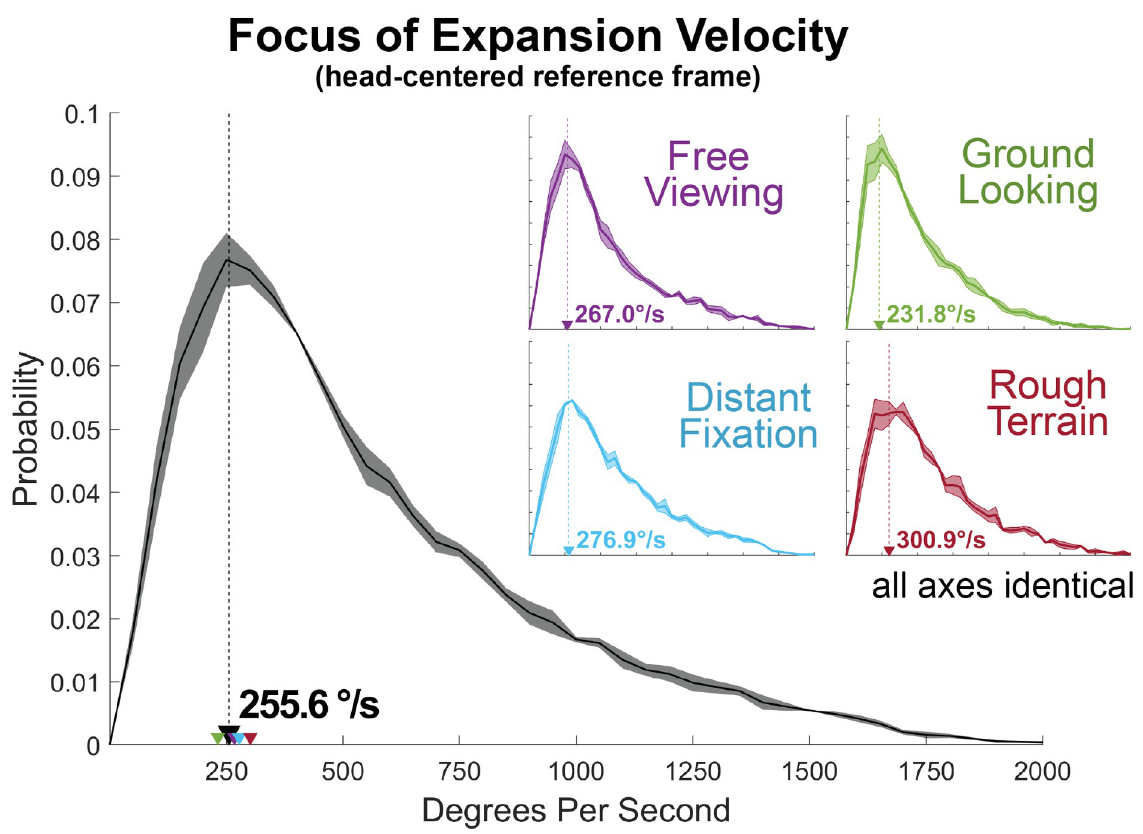
Fig 3. Focus of Expansion velocity in head-centered coordinates. Focus of Expansion velocity across all conditions (black histogram), as well as split by condition (colored insets). The thick line shows the mean across subjects, and shaded regions show +/-1 standard error.